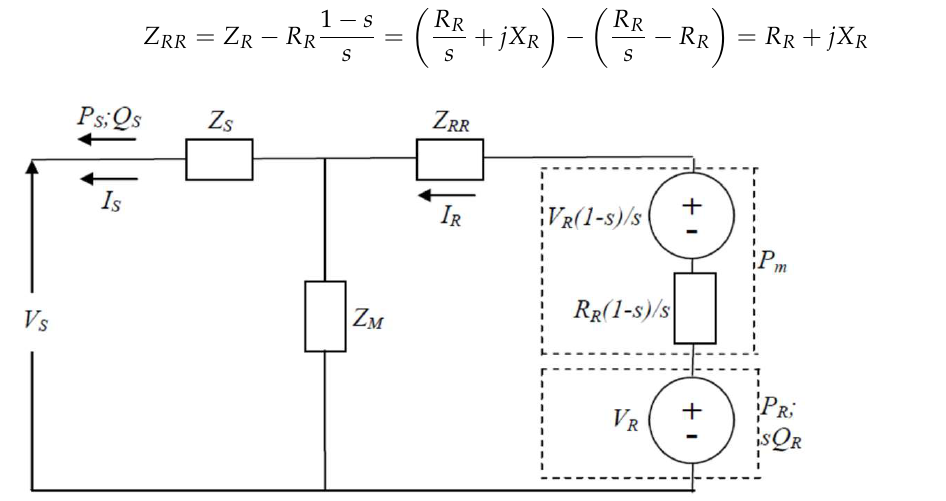
Figure 3. Modified equivalent circuit of DFIG.